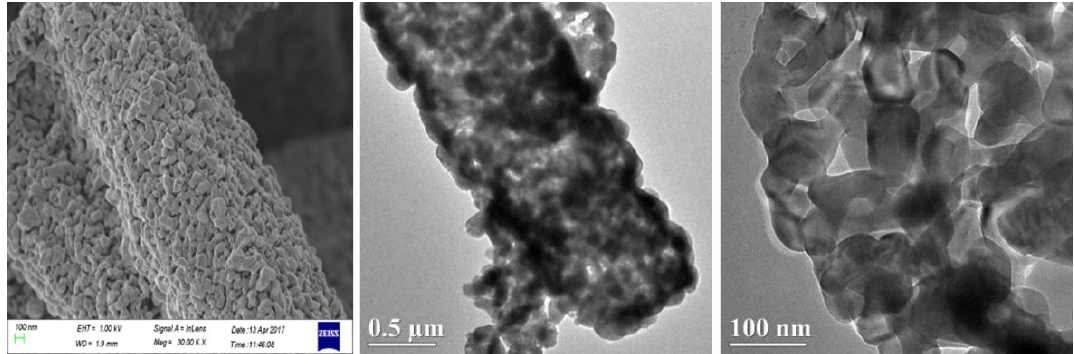
Figure 1. Scanning electron microscopy (SEM) (left) and high-resolution transmission electron microscope (HRTEM) (middle and right) of Mn 3 O 4 -300.